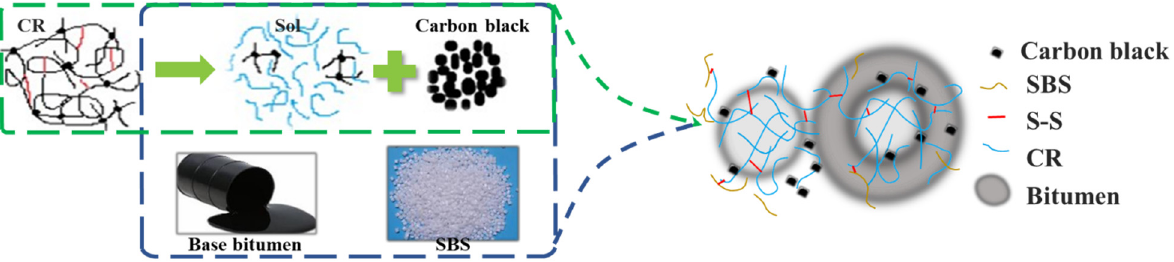
Figure 4. Modification mechanism of SBS/DCRMB.